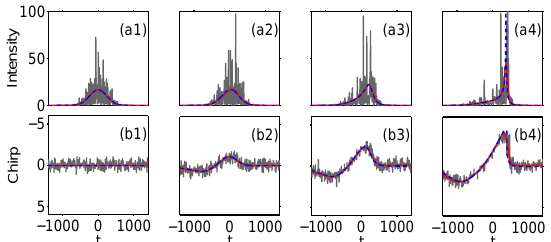
Figure 1. Numerical simulations of the NLS Equation (1) (gray line), of the Vlasov Equation (2) (red line), and of the hydrodynamic-like Equation (3) and (4) (blue line). ( a ) Evolution of the intensity of the field that develops a collapse singularity, and corresponding evolution of the momentum (chirp) that develops a shock singularity ( b ). The quantitative agreement between the different models is obtained without using adjustable parameters. Propagation lengths at z = 0,60,130,200 from left to right, τ R = 300, σ = − 1.